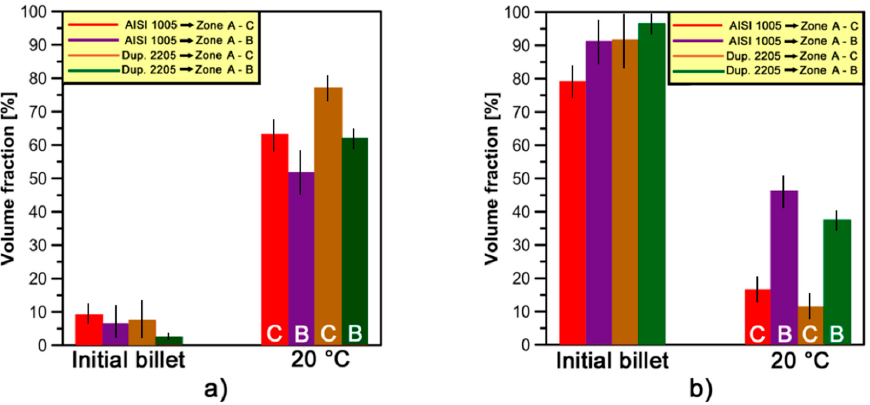
Figure 8. Volume fractions of: ( a ) LABs; and ( b ) HABs developed in γ -phase for AISI 304L and DDS 2205 samples at 20 °C and different strain levels.